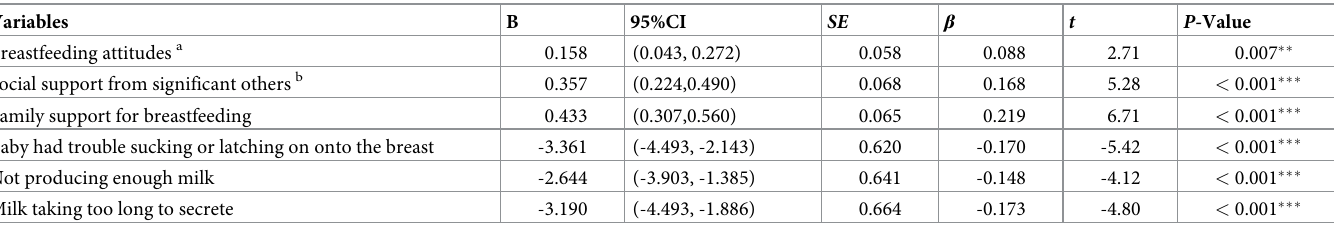
Table 6. Determinants of breastfeeding self-efficacy among postpartum women in rural China, linear regression model (N = 787). Variables